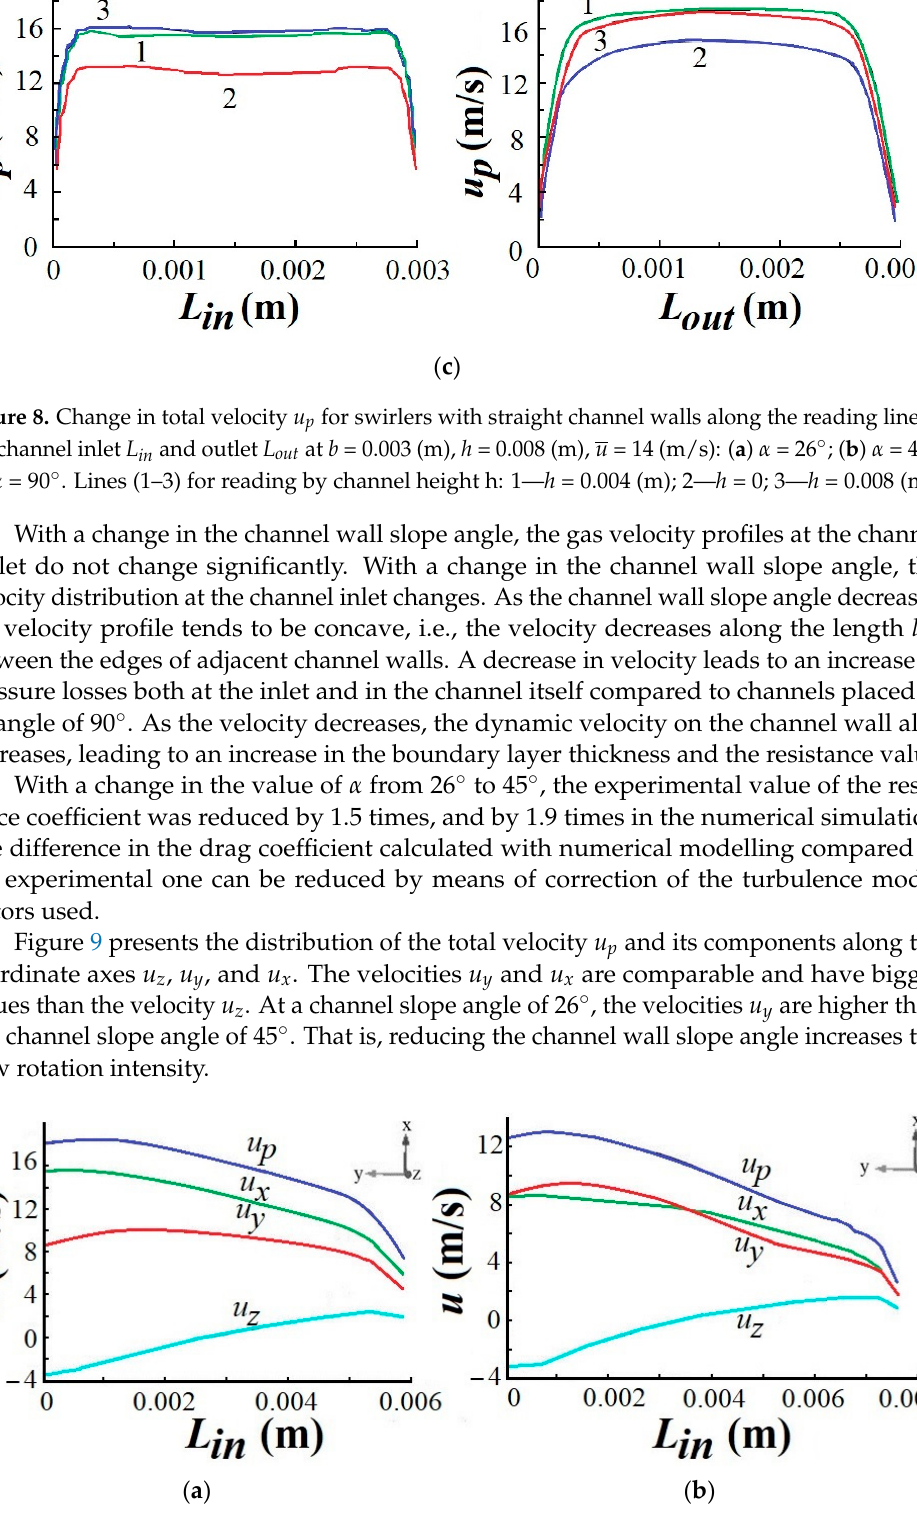
Figure 9. Distribution of the total velocity u p and its components along the coordinate axes u x , u y , and u z at channel wall slope angle α = 26° ( a ) and α = 45° ( b ): Straight channel walls.